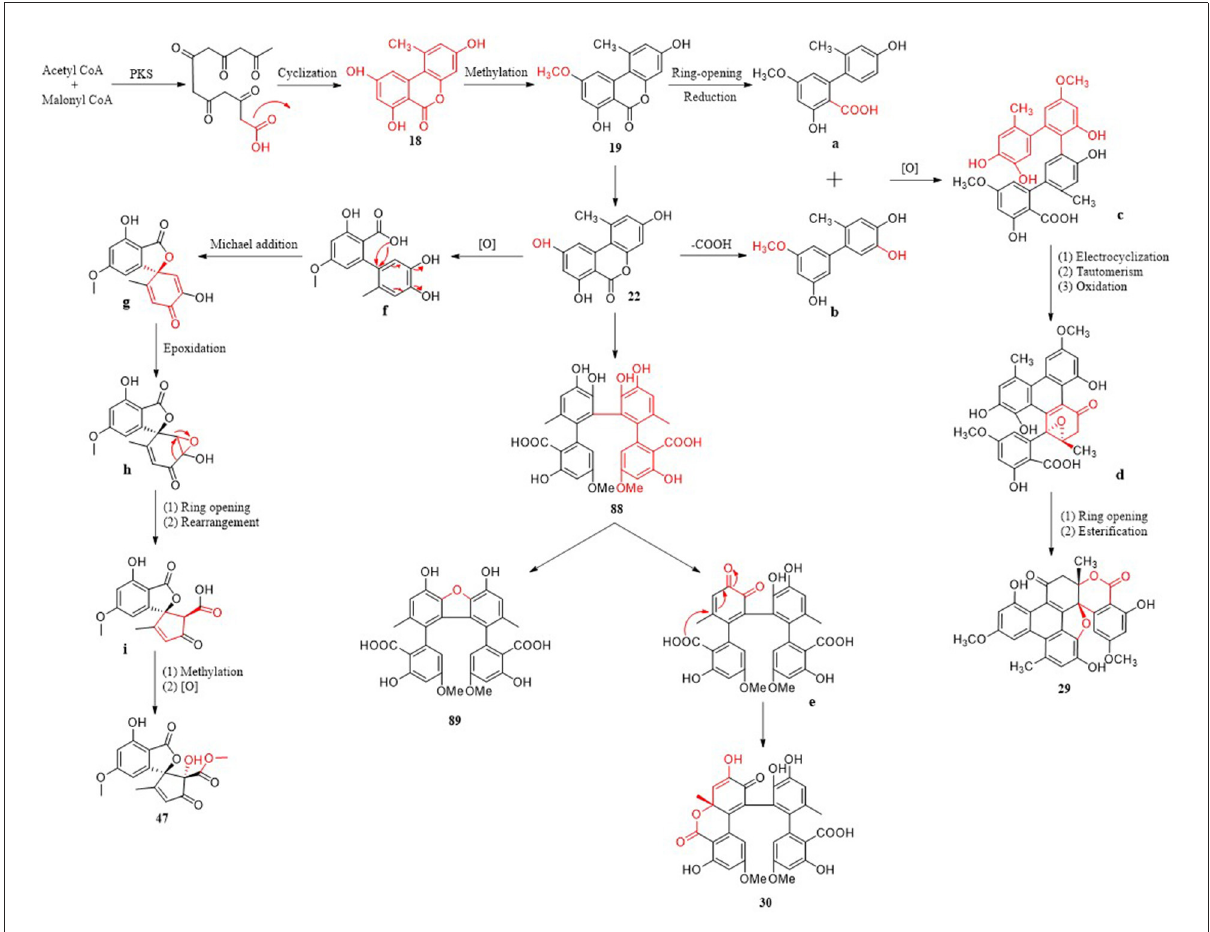
FIGURE14 Possible biosynthetic pathway of polyketones.